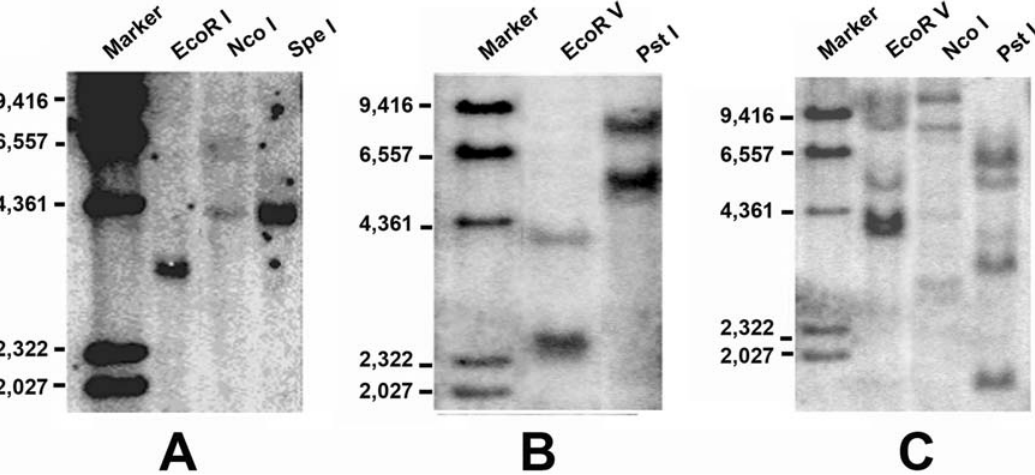
Figure 5. Southern blot analysis. Genomic DNA from Branchiostoma belcheri tsingtauense was digested with restriction enzymes as indicated. The blot was hybridized with a probe at high stringency with the full-length of Ikaros-like, Bam32 and TAPP1 from amphioxus. doi:10.1371/journal.pone.0000206.g005 PLoS ONE |